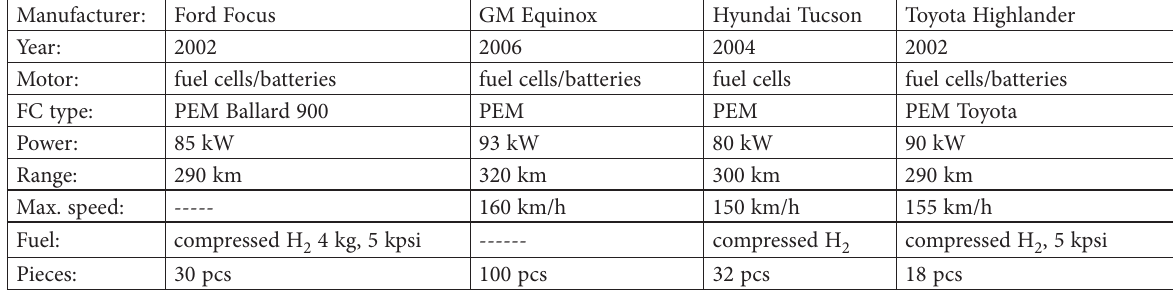
Table 2. Examples of